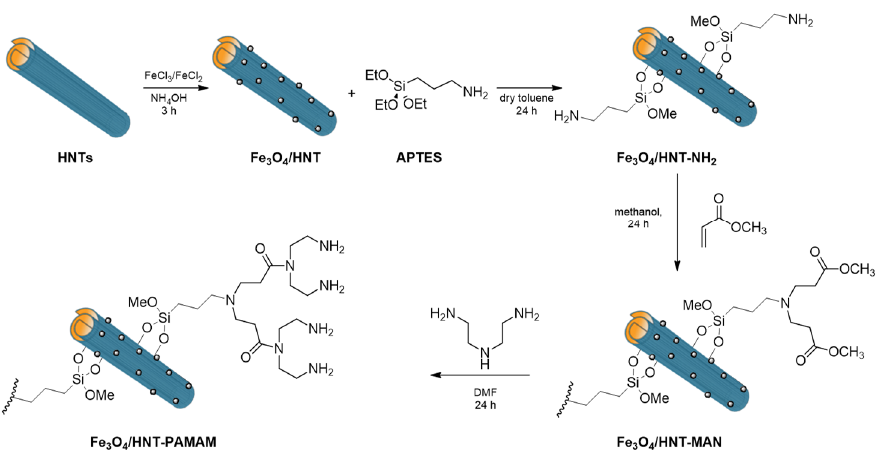
Figure 8. Scheme of the synthesis of poly(amidoamine) PAMAM modified Fe 3 O 4 @HNTs-NH 2 Figure8. Schemeofthesynthesisofpoly(amidoamine)PAMAMmodifiedFe 3 O 4 @HNTs-NH 2 nanomaterial.